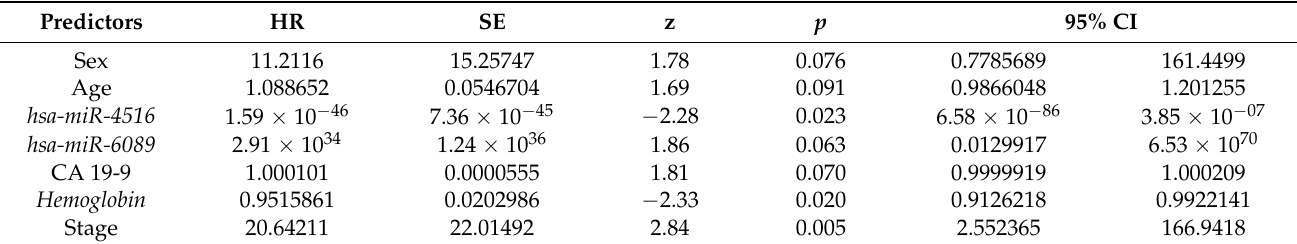
Table 4. Cox regression analysis in the validation cohort. Dependent variable: PDAC patients’ survival.